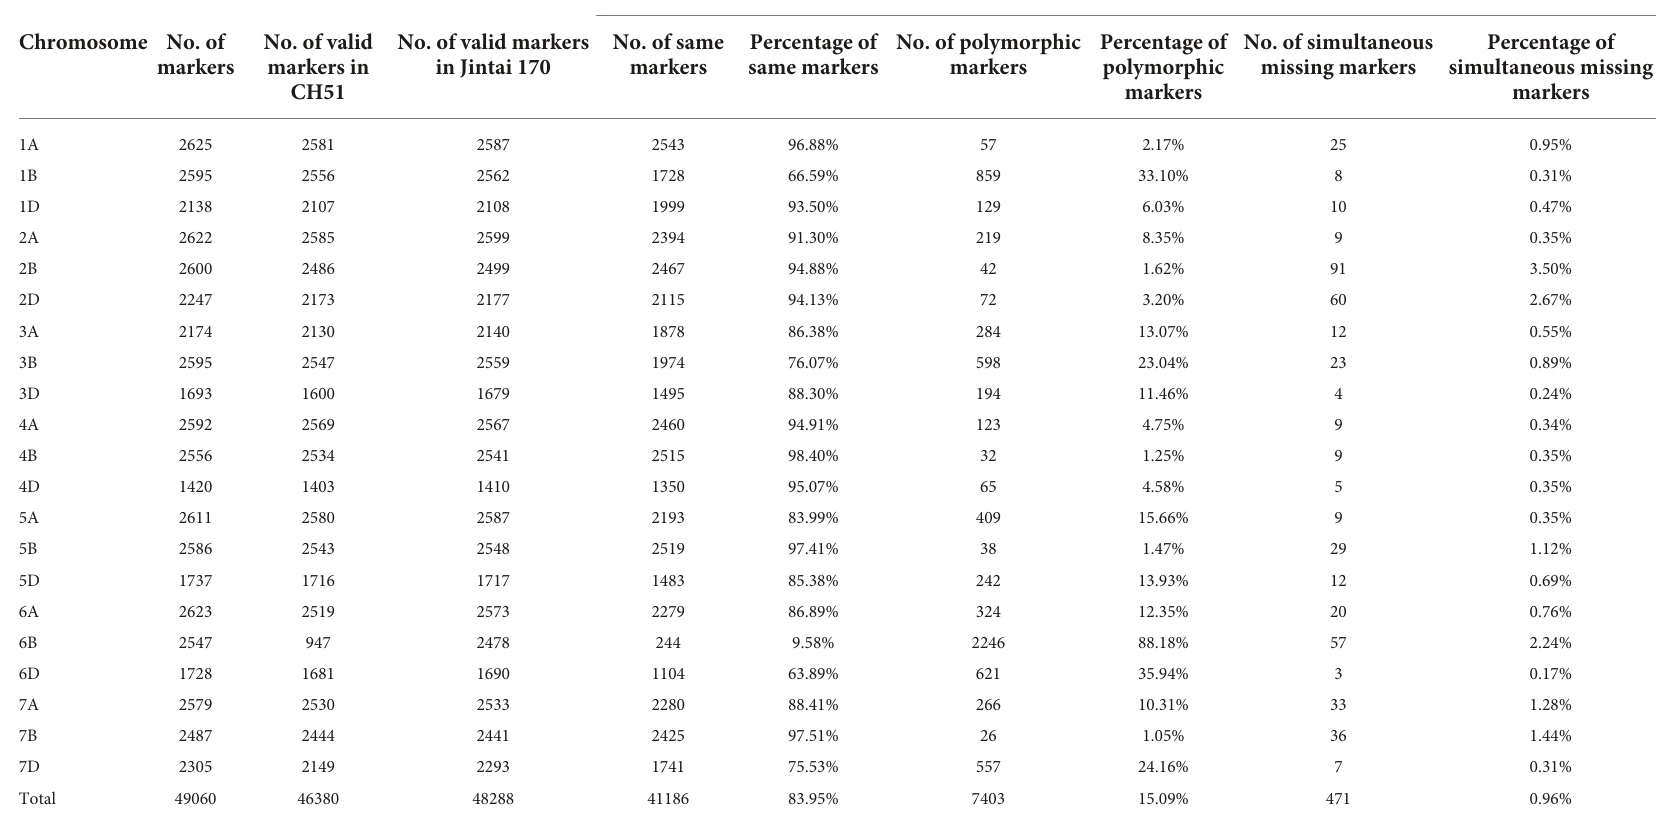
CH51 vs. Jintai 170